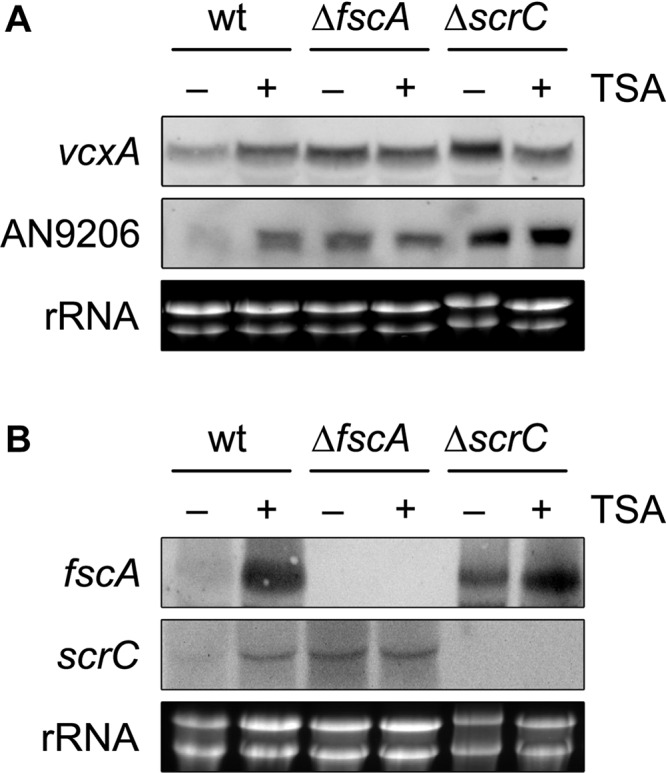
KDAC inhibition by TSA leads to de-repression of crzA targets and RcLS2F-specific genes. Expression of the CrzA targets vcxA and AN9206 (A) and of the RcLS2F components scrC and fscA
(B) detected by northern analysis is displayed. Fungal strains (2 × 106 conidia per ml) were grown in MM including appropriate supplements for 18 h and subsequently were challenged by the addition of 1 μM of Trichostatin A (TSA) for 30 min. Corresponding transcripts were visualized by northern analysis using 12.5 μg of total RNA and DIG-labeled probes. Ethidium bromide stained rRNA was used as quality and loading control.